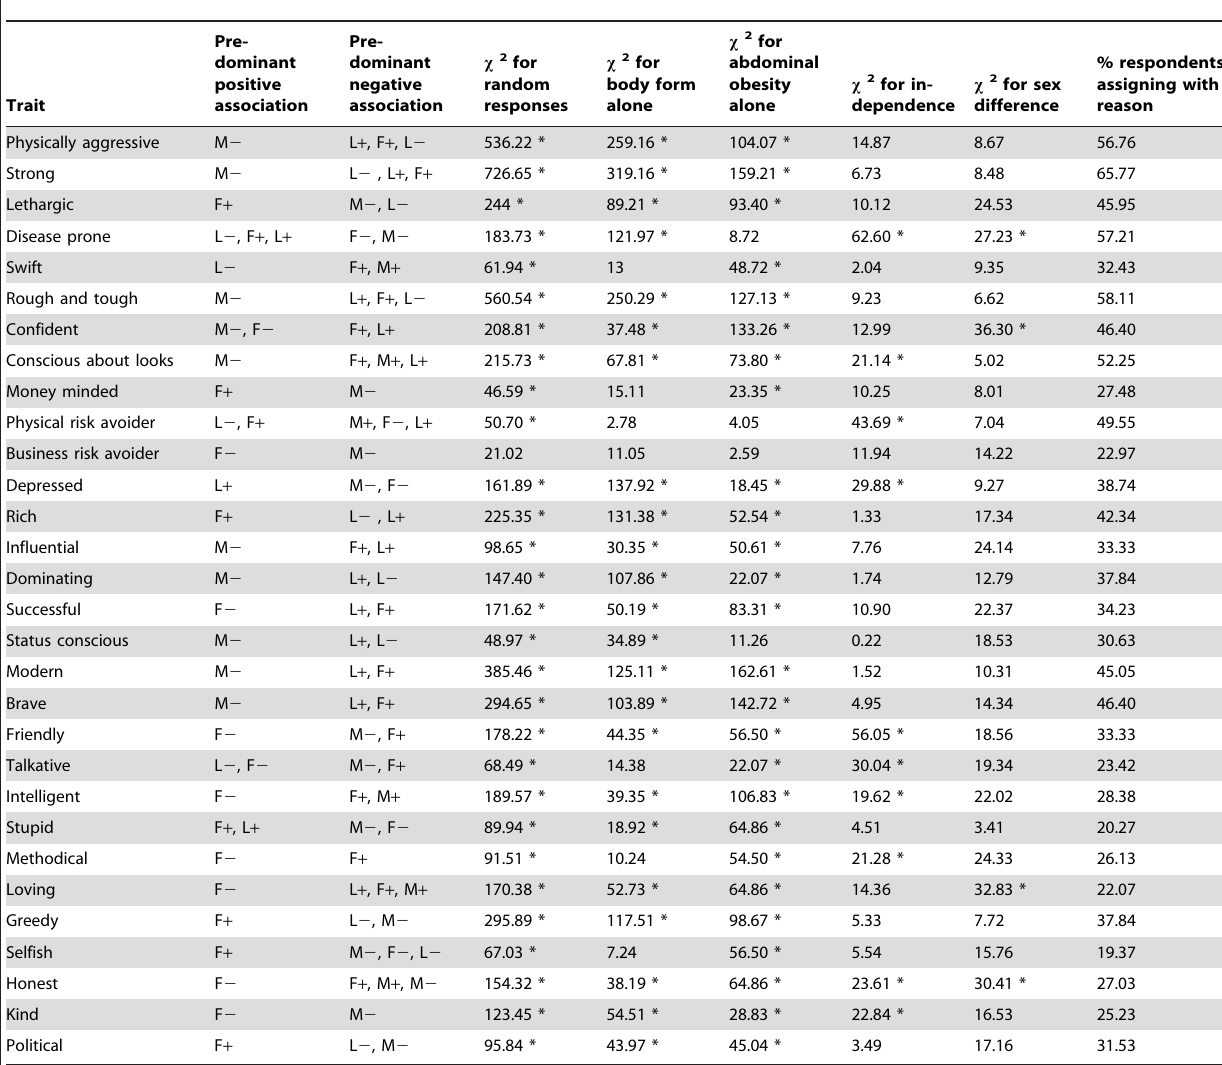
Table 1. Predominant positive and negative associations of personality traits with different body forms: